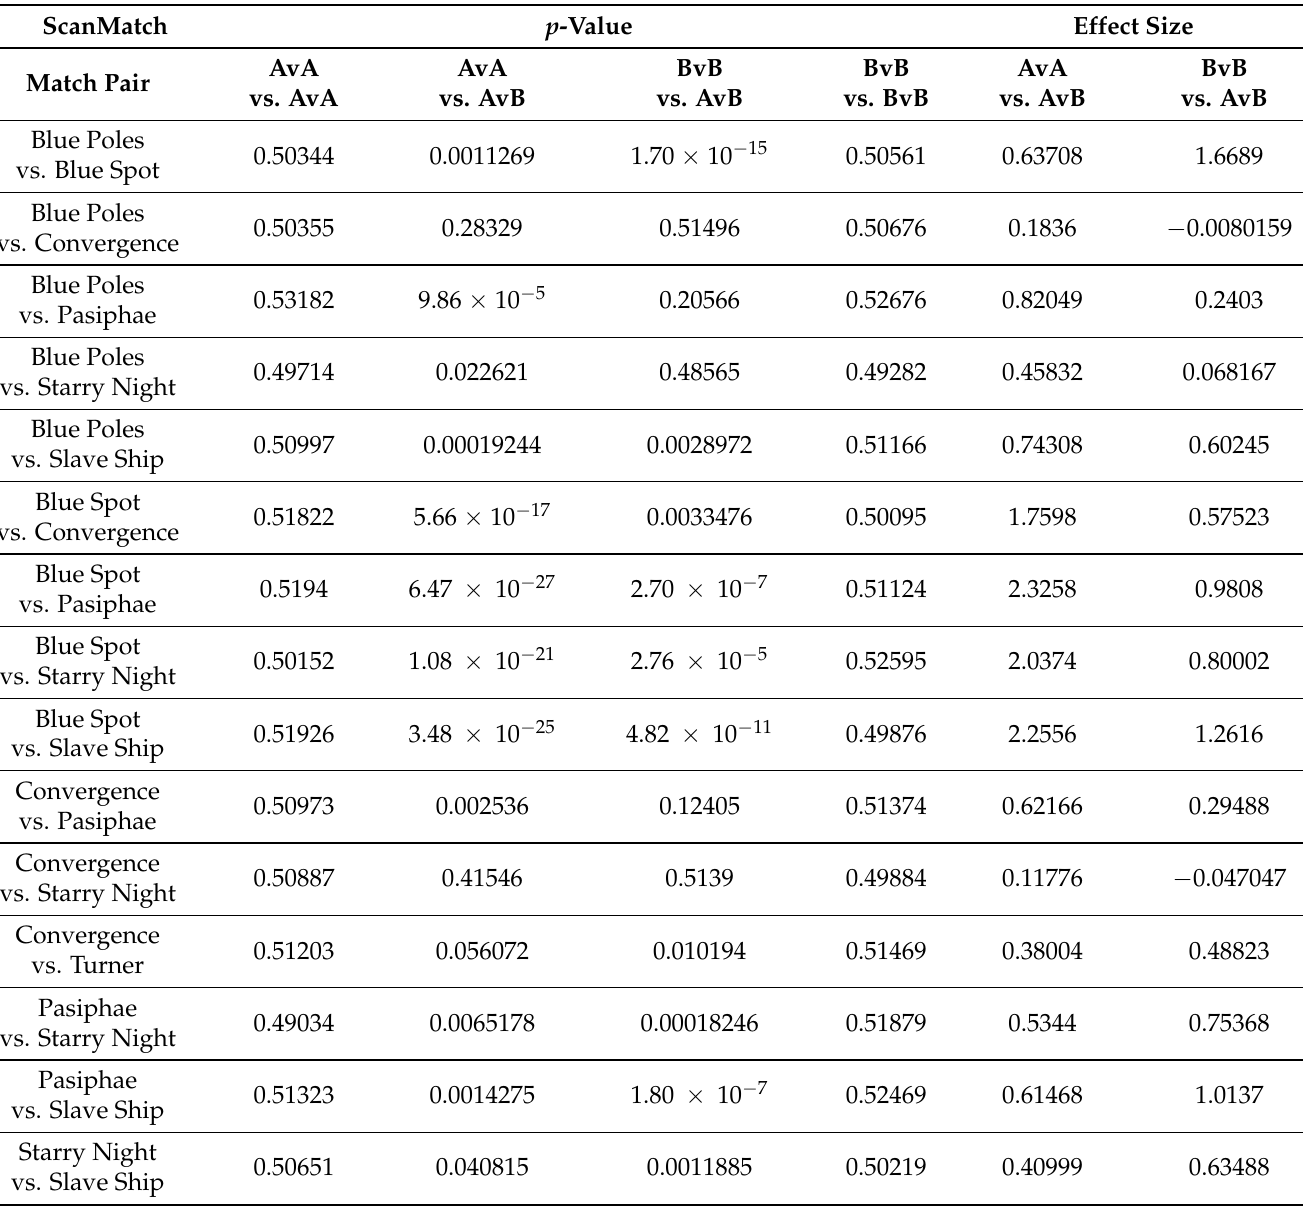
Table A2. ScanMatch results. Match pair (e.g., Blue Poles vs. Blue Spot), where AvA, AvB, and BvB represent match scores based on a comparison of the one member of the pair with itself, or the first member of the pair ( A ) (e.g., Blue Poles) and the second member, B (e.g., Blue Spot). The effect size for (AvA vs. AvA) and (BvB vs. BvB) in all cases was